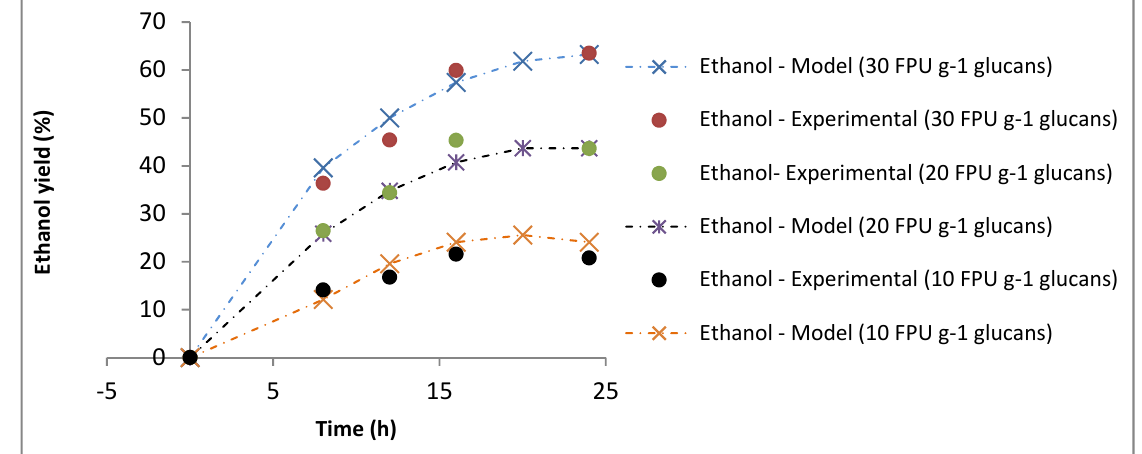
Figure 3. Experimental and theoretical (calculated using Model I) fermentation yields at 39 ◦